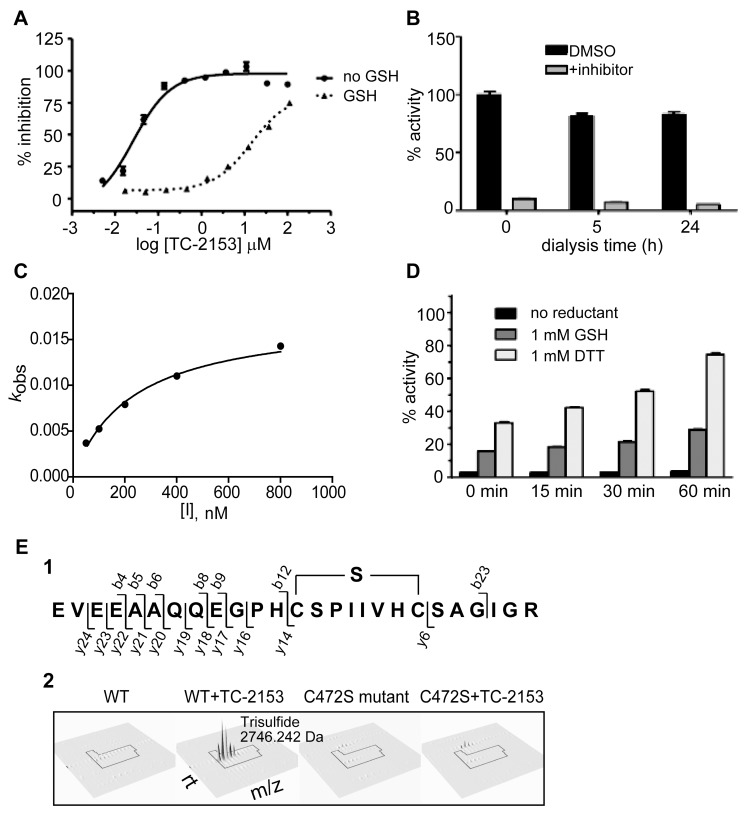
TC-2153 targets the active site cysteine of STEP.(A) STEP activity was measured with pNPP and IC50s were 24.6±0.8 nM and 8.79±0.43 µM in the absence and presence of 1 mM GSH (mean ± s.e.m., n = 2). (B) STEP (200 nM) and TC-2153 (1 µM) (or DMSO control) were incubated for 60 min to inhibit enzymatic activity prior to dialysis. Aliquots were tested against pNPP (mean ± s.e.m., n = 4). (C) The progress curve method was used to determine the second-order rate constant: k
inact/K
i = 153,000±15,000 M−1s−1 (mean ± s.e.m., n = 4). (D) STEP (200 nM) and TC-2153 (5 µM) were incubated for 10 min and then incubated with GSH or DTT (1 mM each) or water (no reductant) for 0, 15, 30, or 60 min, and the enzymatic activity of STEP was measured using the pNPP assay (mean ± s.e.m., n = 4). (E) Detection of trisulfide bridge formation between C465 and C472. The peptide sequence in (1) illustrates the trisulfide bridge along with the b and y-ion assignments detected in the MS/MS fragmentations spectrum (see Figure S6). (2) compares the 3D elution profile of the trisulfide peptide (mass  = 2,746.242 Da). The trisulfide bridge (modified) peptide is only detected in the WT STEP in the presence of TC-2153. The corresponding disulfide (non-modified) peptide (mass  = 2,714.254 Da) was detected in WT STEP (see Figure S6).